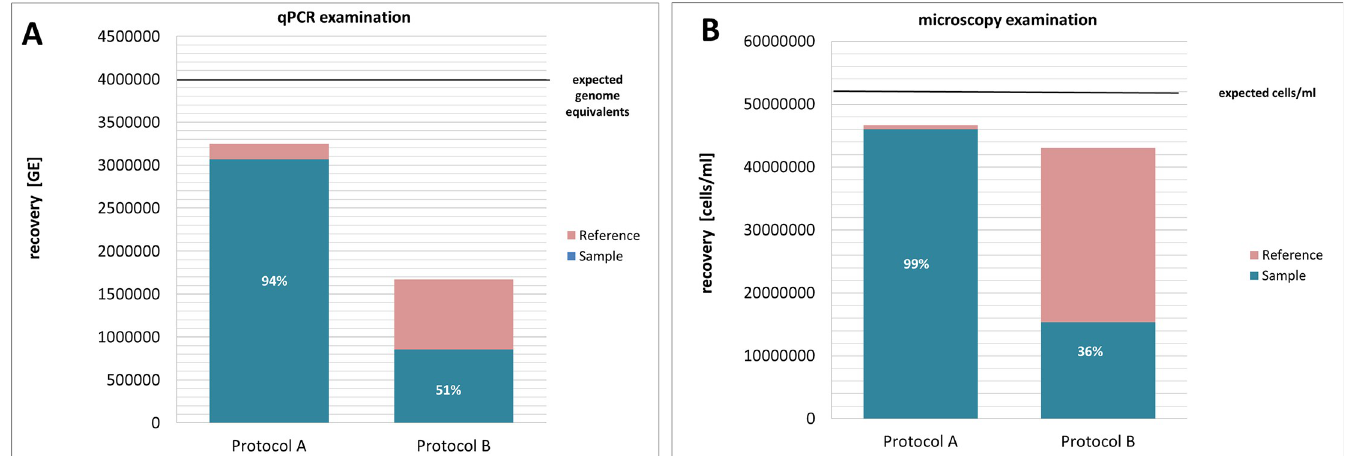
Fig 1. Recovery of Leptospira kirschneri from strawberries using the washing protocol (protocol A) and the homogenization protocol (protocol B) after spiking 5x10 9 leptospires on the strawberry surface. Examination of bacterial recovery with qPCR (A) and by microscopy (B). The recovery rate was calculated as the ratio between the number of detected bacteria in the sample and the reference sample. The black line shows the expected number of genome equivalents 4,2x10 6 genome equivalents (GE) (A) or 5x10 7 bacteria/ml (B) in the final sample.